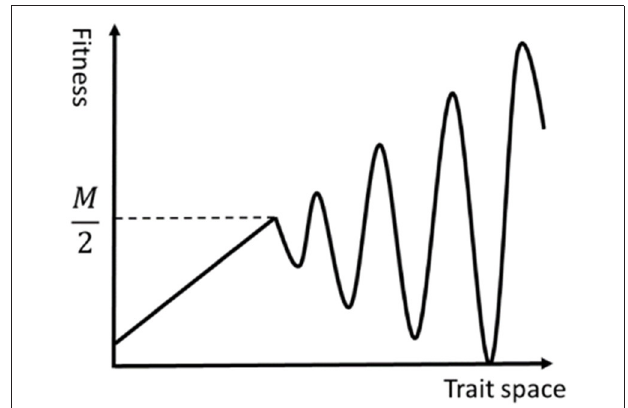
FIGURE 1 | An image of a rugged fitness landscape defined by Equations (1, 2).